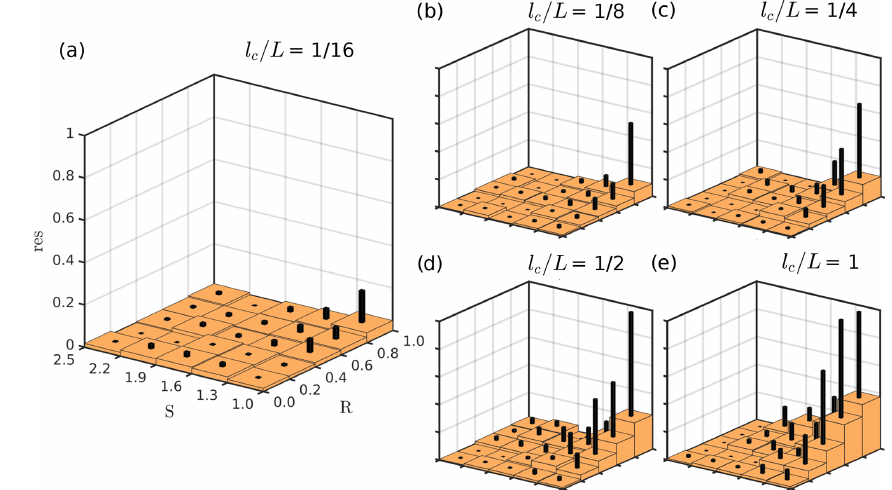
Figure 6. Absolute residual values of the fitted surfaces in Fig. 5 for different l c /L ratios as a function of R and S , binned into equally sized boxes. All axes limits in panel (a) correspond to the ones in panels (b) – (e) . Orange boxes indicate the mean absolute residual value of the specific bin, whereas the smaller black boxes on top give the maximum absolute residual.